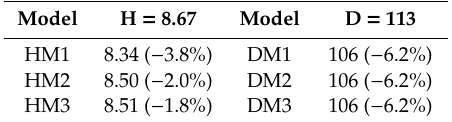
Figure 8. Average height ( a ) and diameter ( b ) of the best genotype within each family selected based on manual measurements (bars) and the HM3 and DM3 models ( ∆ ), respectively. Table 6. Mean heights (m) and diameters (mm) at 12 years of genotypes selected using indicated models when just the best genotype per family was selected. H and D are reference values for selection after manual